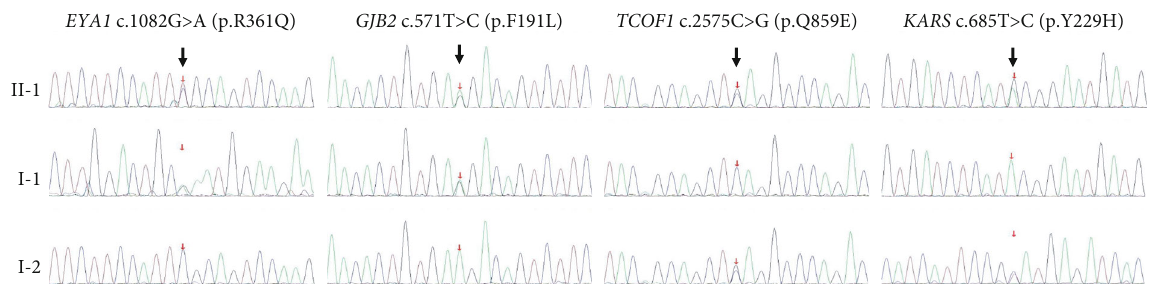
Figure 3: Sequencing diagram of 4 missense variants in patient II-1, una ff ected parents I-1/I-2. Black arrow: changed base